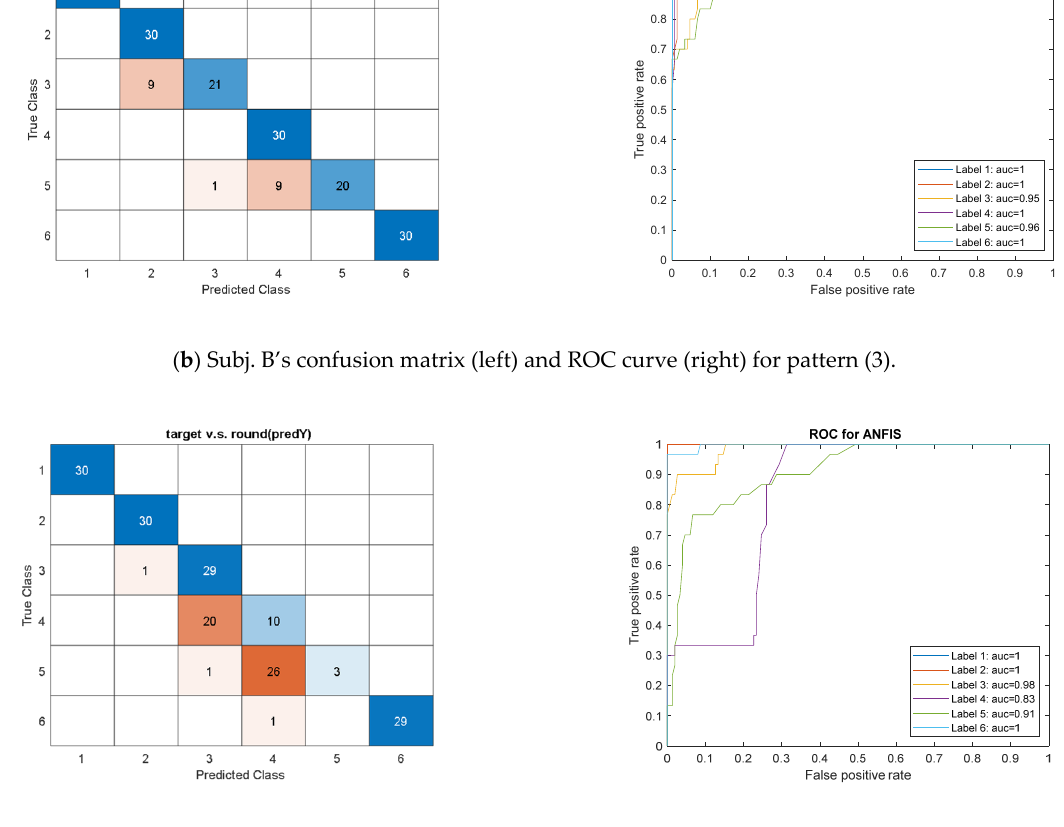
Figure 6. The confusion matrix and one-vs-rest ROC curves for test and validation dataset using the ANFIS model with ( a ) feature pattern (3), (5), (6), (8), (12) for Subject A, ( b ) feature pattern (3), and ( c ) feature pattern (8) for Subject B.